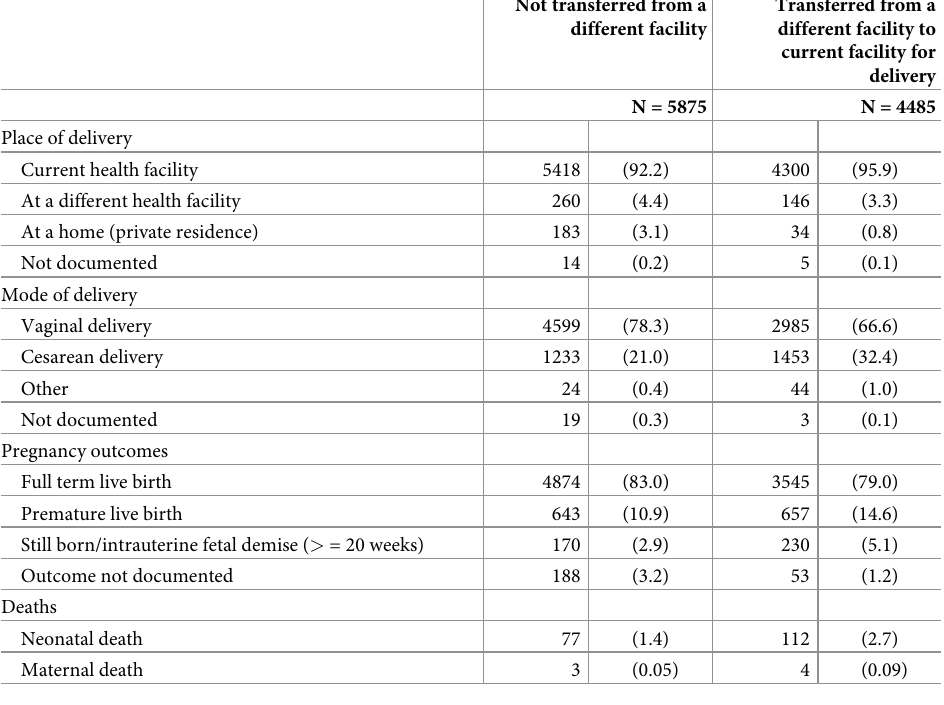
Table 7. Select characteristics by transfer status from a different facility for delivery.